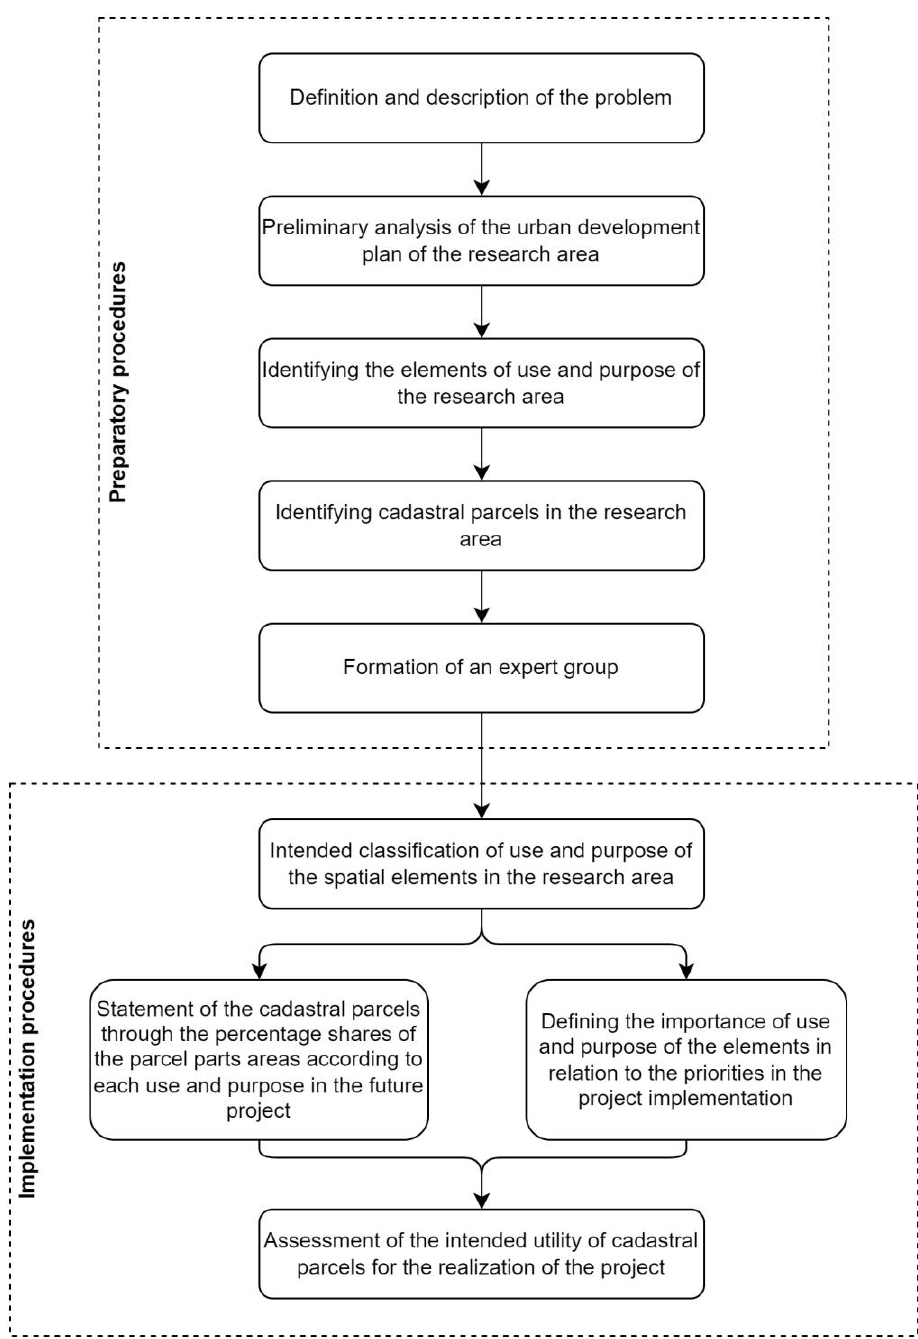
Figure 2. Model of intended utility assessment.